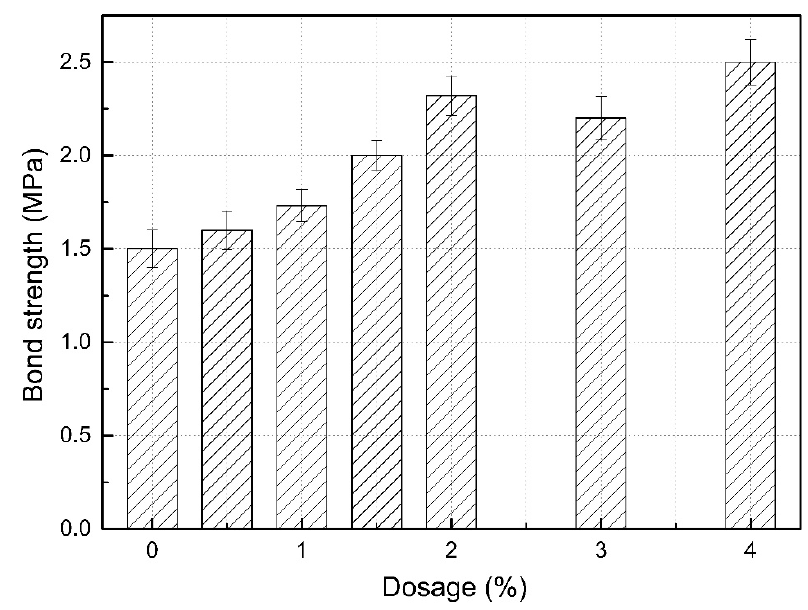
ff erent dosages of RP.